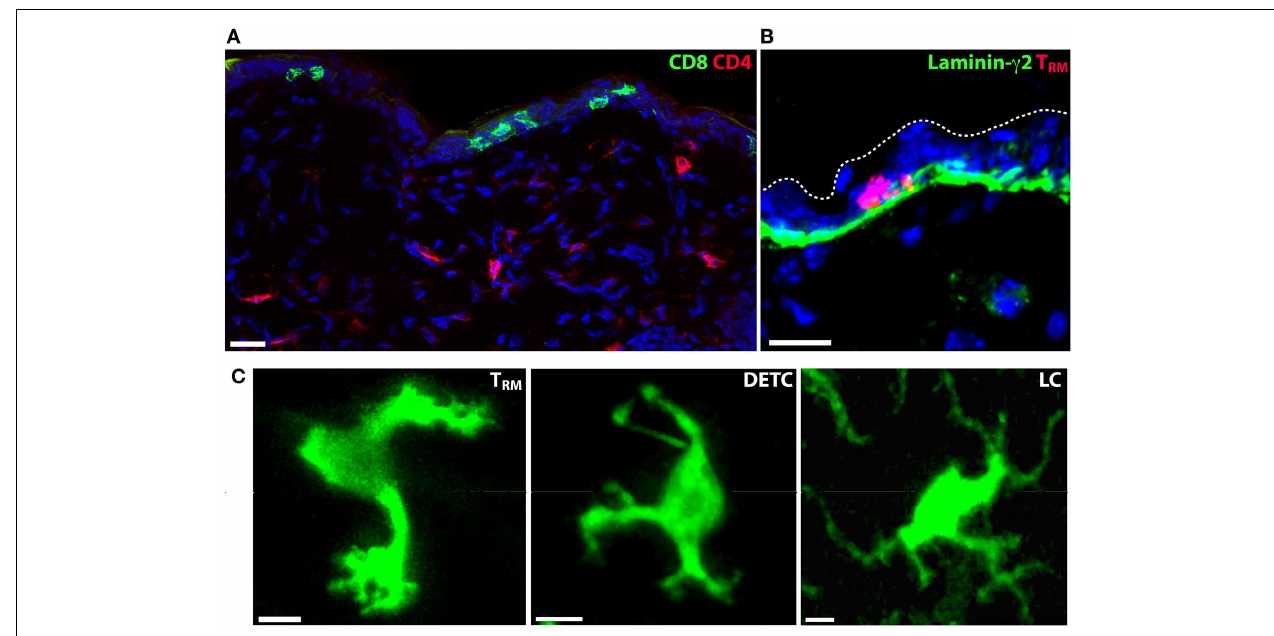
basal epidermis in contact with the basement membrane that separates dermis from epidermis. CD8 + T RM , red; laminin- γ 2, green; DAPI, blue. (C) The morphology of epidermis-residentT RM , LC and DETC is distinct. Scale bars: A, B: 20 µ m; C: 5 µ